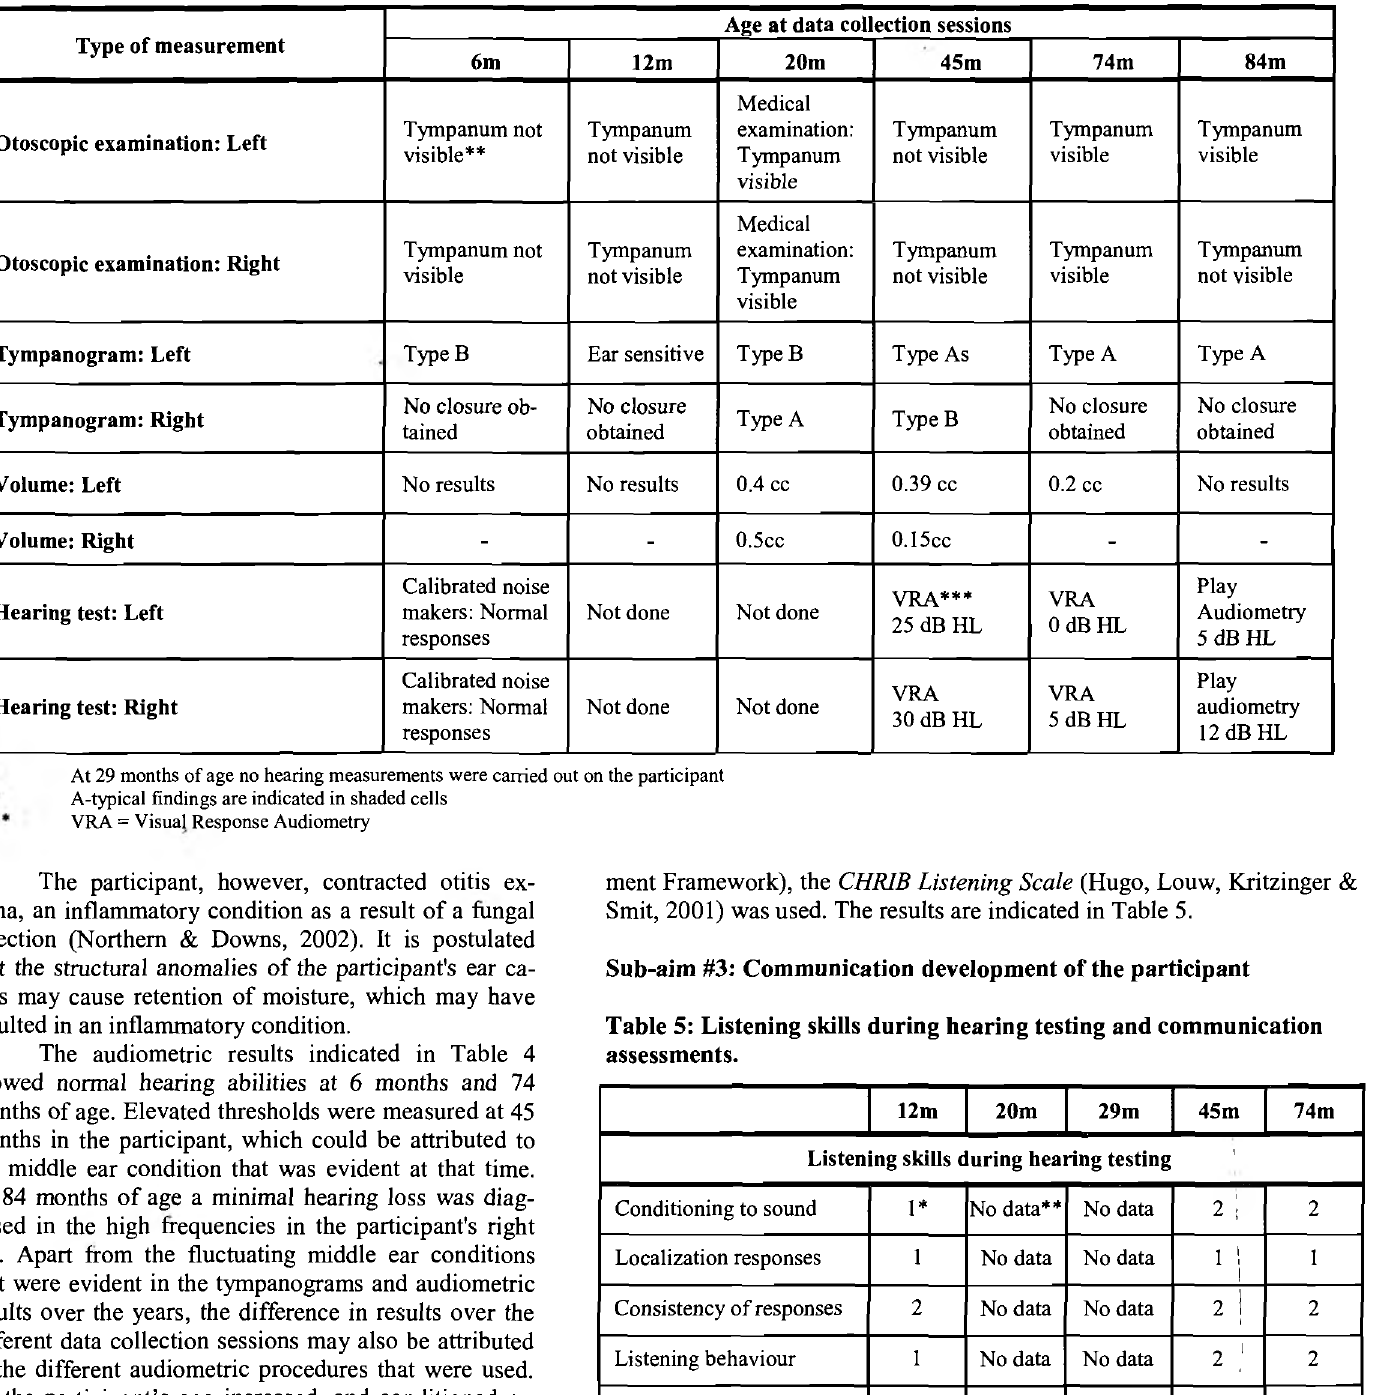
Table 4: Otoscopic examinations, tympanograms, volume measurements of the external auditory meati, and audiometric results at six* data collection sessions.